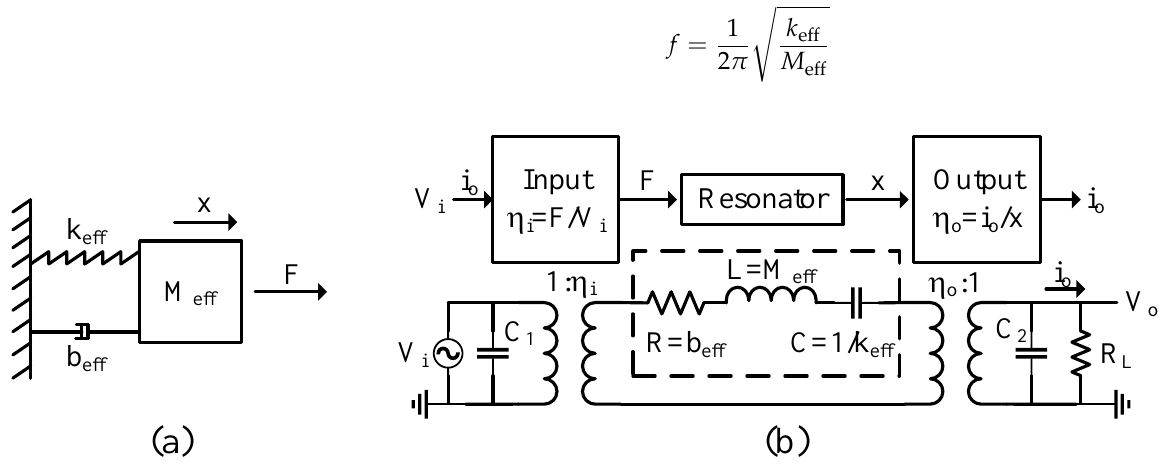
where M eff , b eff , k eff , F , and x are the equivalent effective mass, effective damping con- stant, effective spring constant, the applied external force, and the motion displacement, respectively. Under ideal conditions, the frequency can be calculated by: